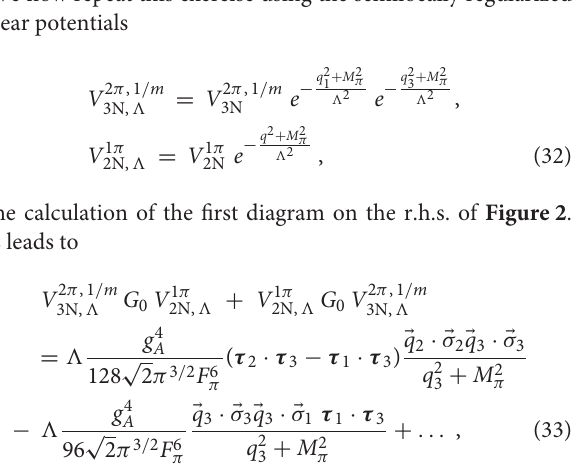
l.h.s. of Figure 1 as expected for consistent two- and three- nucleon